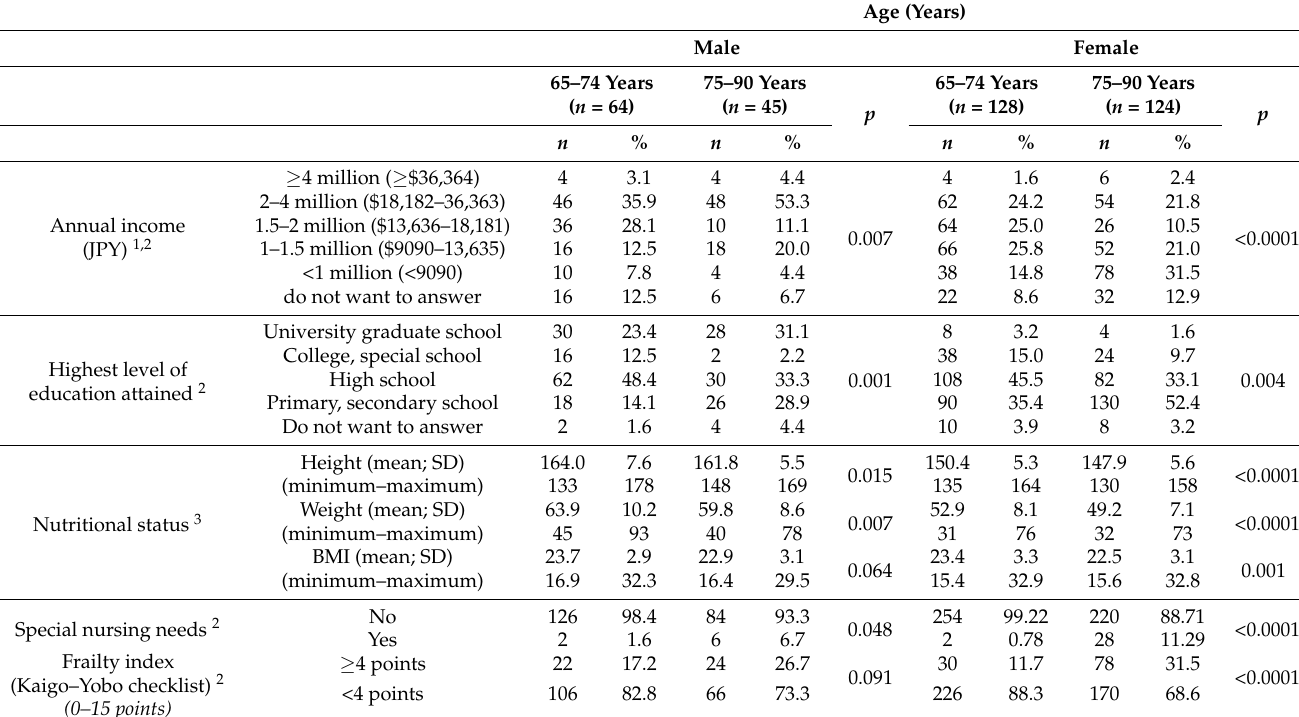
Table 1. Characteristics of the young-old (65–74 years) and old-old (75–90 years) adults.